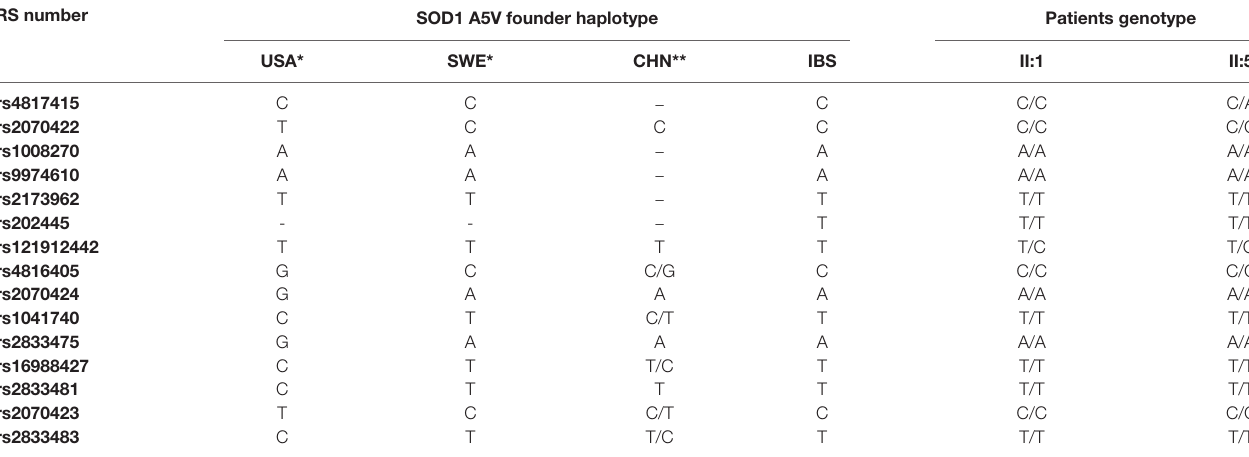
TABLe 1 | SOD1 p.A5V mutation founder haplotype in IBS population compared to other populations. RS number